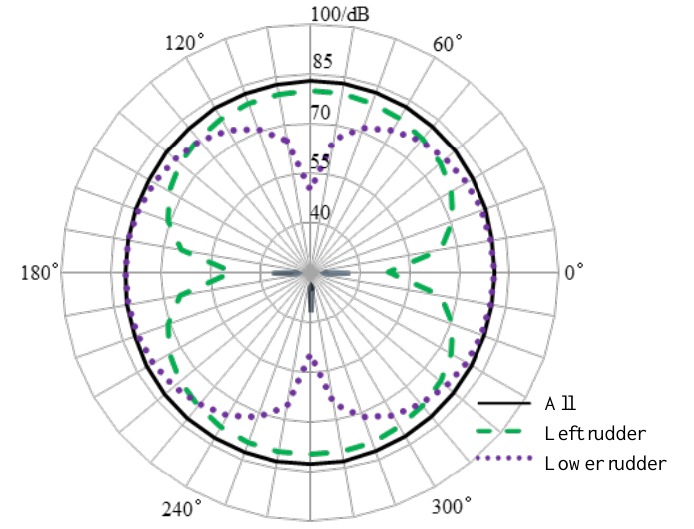
Figure 24. Directivity of sound pressure levels of each rudder surface of the X-type tail part.